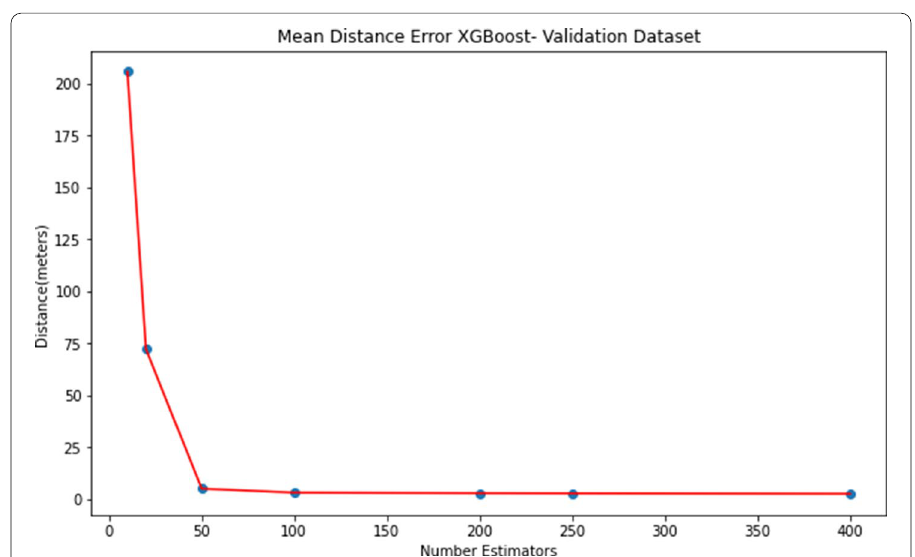
Fig. 11 Estimating model’s error on test dataset for